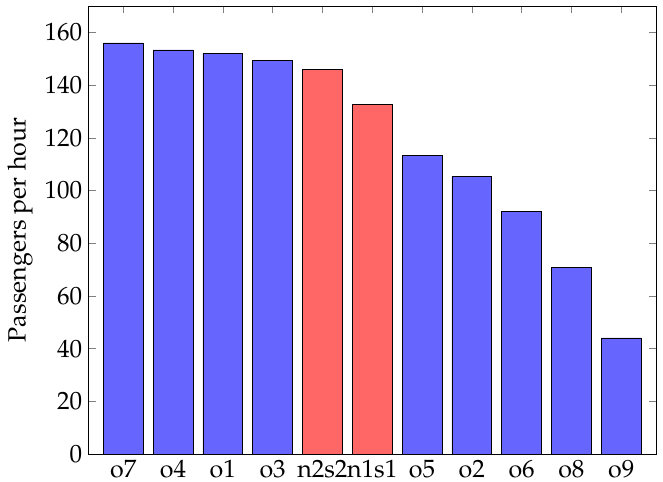
Figure 16. The maximum throughput (normalized to passengers per lane per hour) for the 11 different security checkpoint